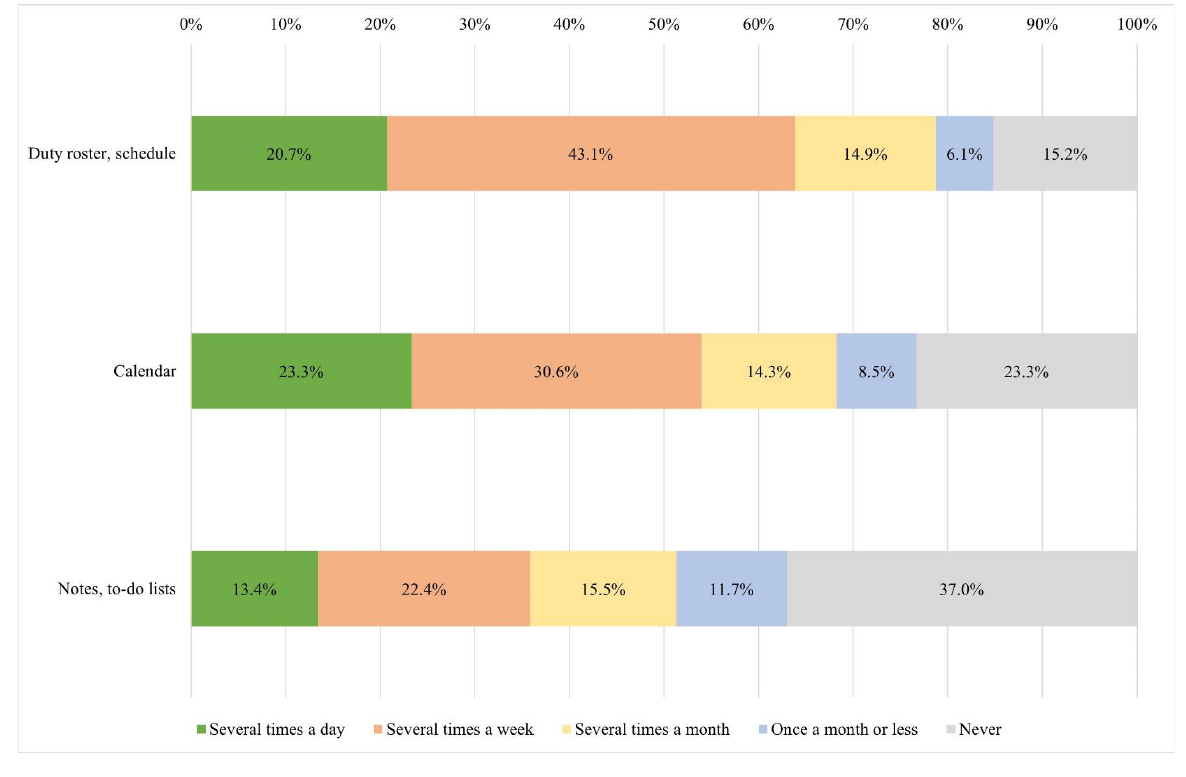
Figure A3. Organization.